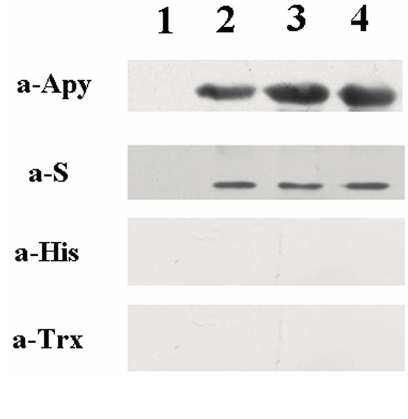
Figure 6. The specificity of expressing bacteria was detected by western blot. Line 1: whole bacteria of before induce; Line 2: whole bacteria of after induce; Line 3: supernatant of the ultrasound crushing; Line 4: precipitate of the ultrasound